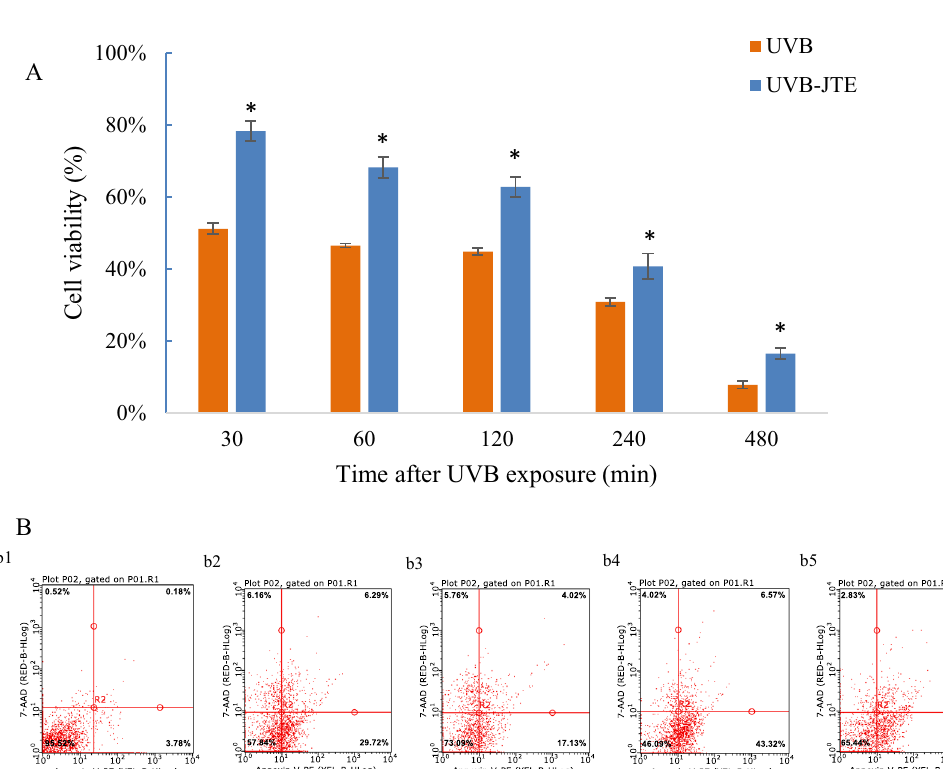
Fig.1 The cell viability ( A ) and flow cytometer determination ( B ) of different treated cells. A RPE cells exposed to UVB irradiation then treated with or without JTE treatment for 30, 60, 120, 240, 480 min. The viability of UVB and UVB-JTE treated cells was calculated by comparing with normal cells. Statistical comparisons were performed between groups treated with same time ( P < 0.05). B The flow cytometer analysis of the apoptosis of various treated RPE cells. b1: normal cell; b2: 30 min after UVB irradiation; b3: 30 min after UVB irradiation and sequential JTE treated; b4: 120 min after UVB